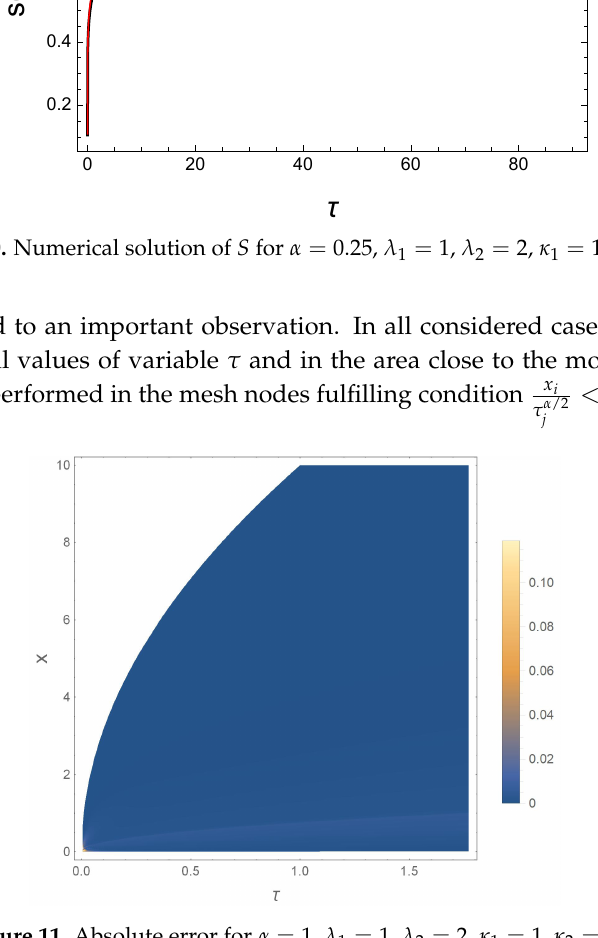
Figure 11. Absolute error for α = 1, λ 1 = 1, λ 2 = 2, κ 1 = 1, κ 2 =